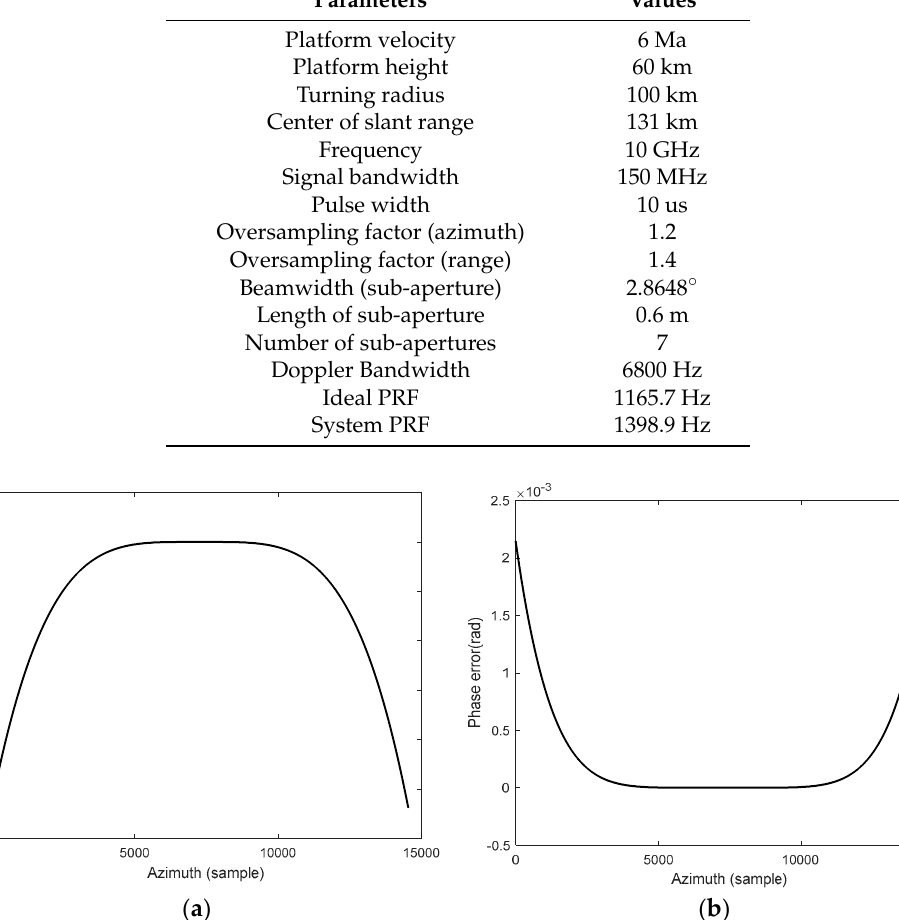
Figure 4. SAR azimuth phase errors introduced by approximate expansion of slant range: ( a ) Second-order Taylor series expansion; ( b ) fourth-order Taylor series expansion.